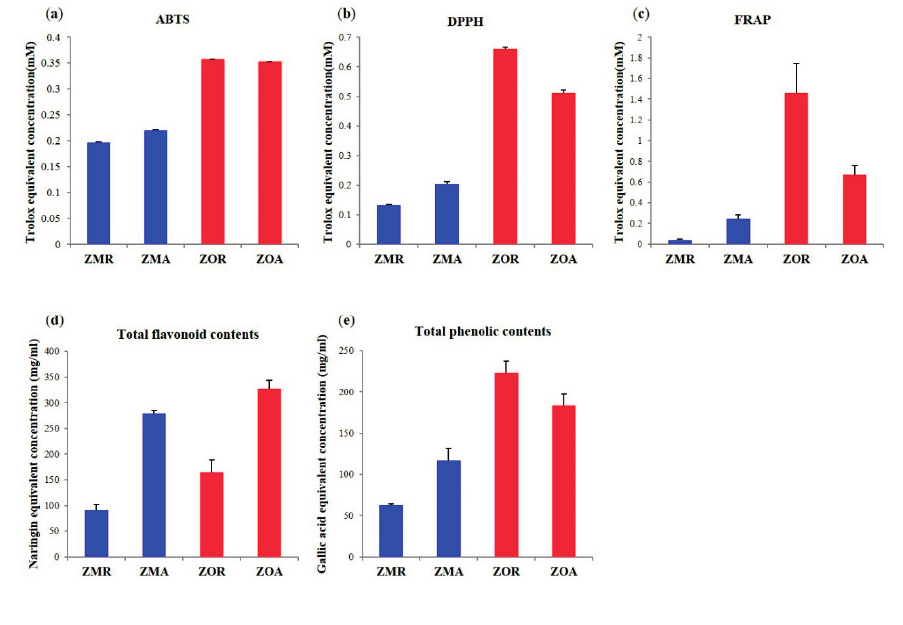
Figure 3. Antioxidant activity assay, ABTS ( a ), DPPH ( b ), and FRAP( c ), total flavonoid contents ( d ) and total phenolic contents ( e ) of Z. officinale and Z. mioga with the two different structural